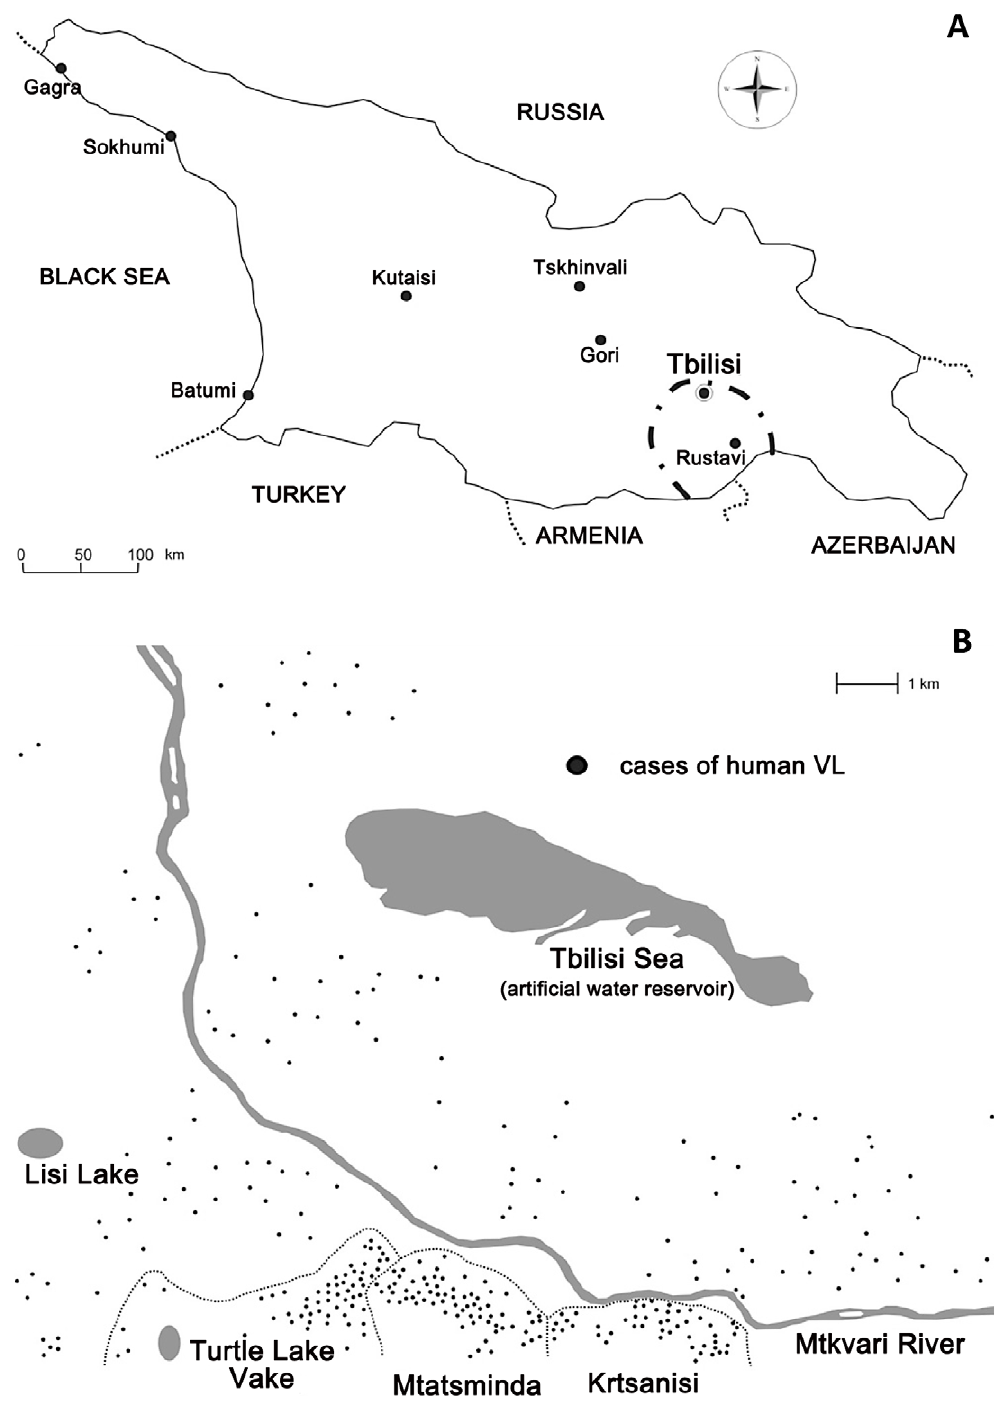
Figure 1. Maps showing distribution of human cases of visceral leishmaniasis in Georgia. Map of Georgia (A) showing the principal active foci of VL in Tbilisi and Shida Kartli region (outlined by — ? —). Map of Tbilisi (B) showing distribution of VL cases and location of Krtsanisi, Mtatsminda, and Vake districts surveyed in this study.